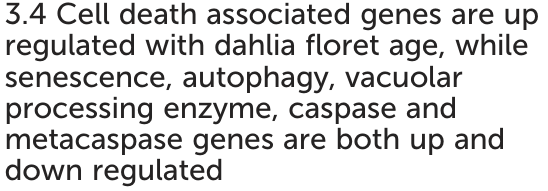
were common to all fl oret stage comparisons (Figure 2C). An overall analysis of GO annotations comparing the effects of position in the head or head age show that although similar functional classes are represented, their relative proportions differ (Figure 3). For example, the largest proportion of the genes are assigned to translational proteins in DEGs between head ages, while the largest proportion of genes are assigned to metabolite interconversion and nucleic acid binding functions in DEGs between head positions.